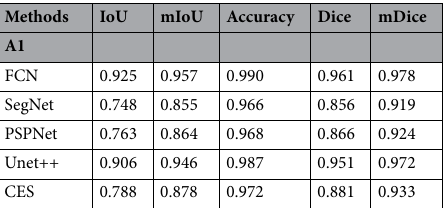
Table 2. The IoU (blue area), mIoU, Accuracy, Dice (blue area) and mDice of Image A1 using fully supervised deep learning methods and our CES method which is trained on group B.